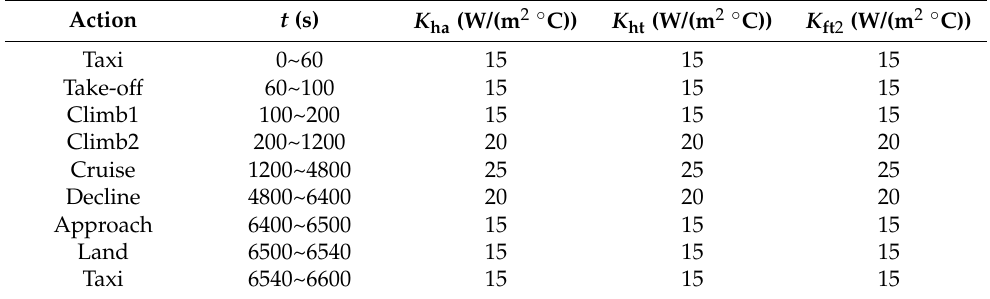
Table 3. The heat transfer coefficients of hydraulic actuating subsystem, tank, and fuel